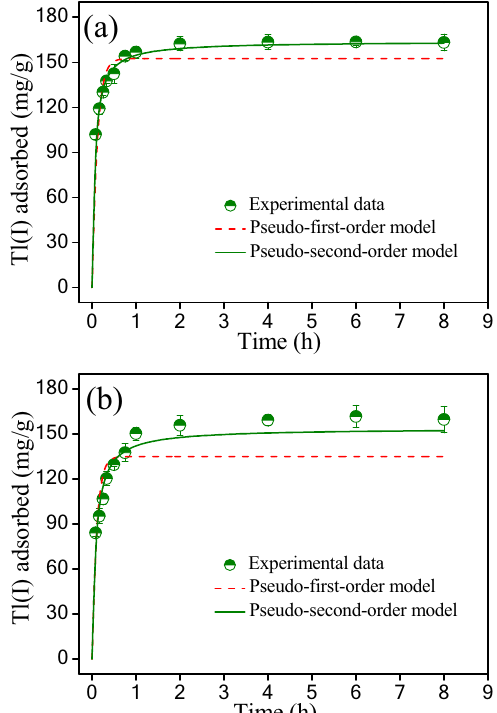
Figure 5. Kinetics of Tl(I) adsorption on TiO 2 I ( a ) and TiO 2 II ( b ). Experiment conditions: Initial Tl(I) concentration = 34.5 mg/L; adsorbent dosage = 0.2 g/L; pH = 7.0 ± 0.1 and T = 25 ± 1 °C.